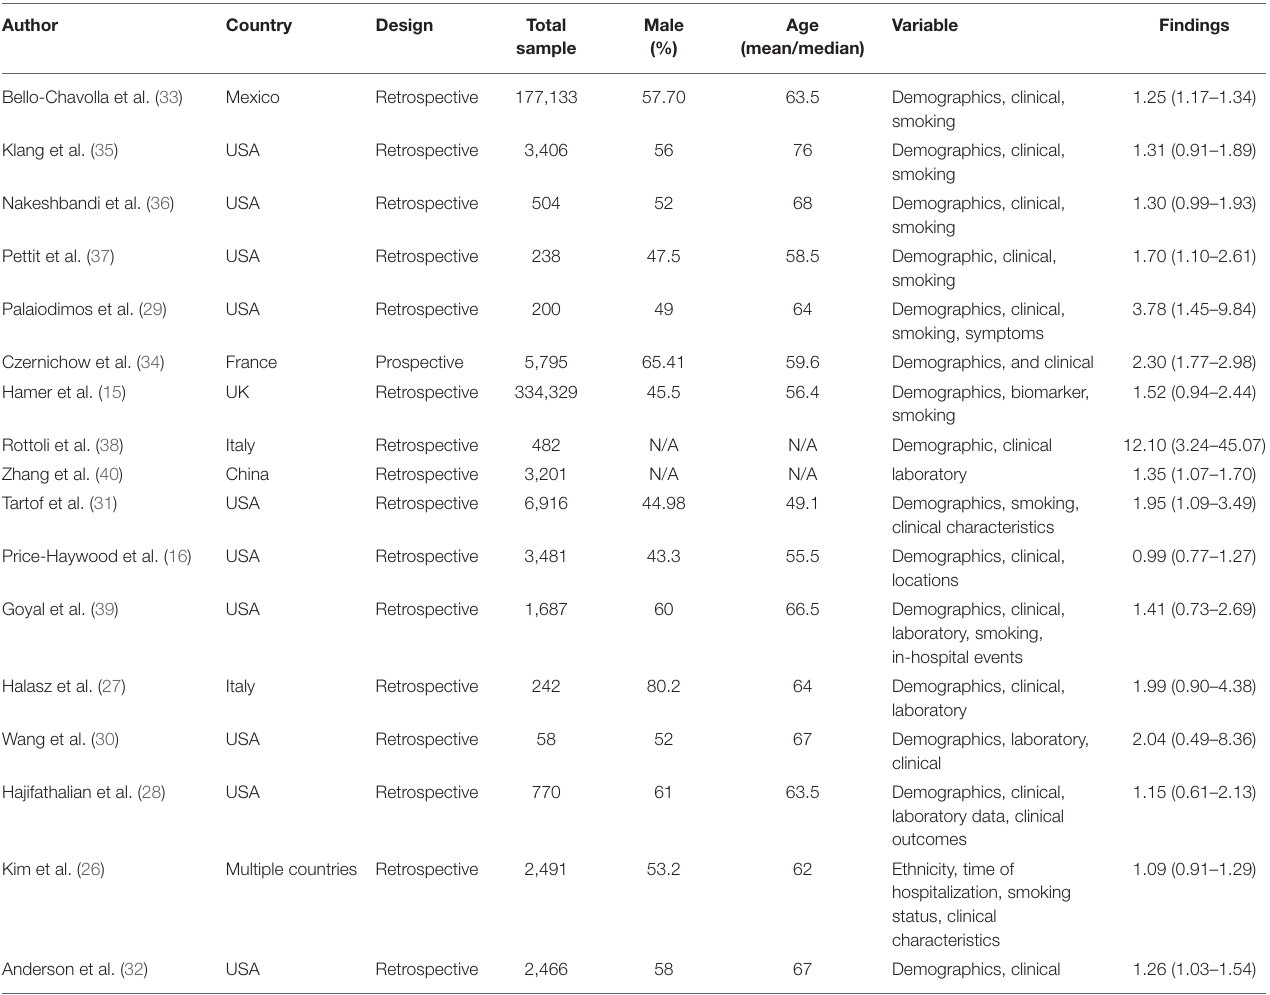
TABLE 1 | Characteristics of the included studies assessing the risk of mortality of COVID-19 patients with